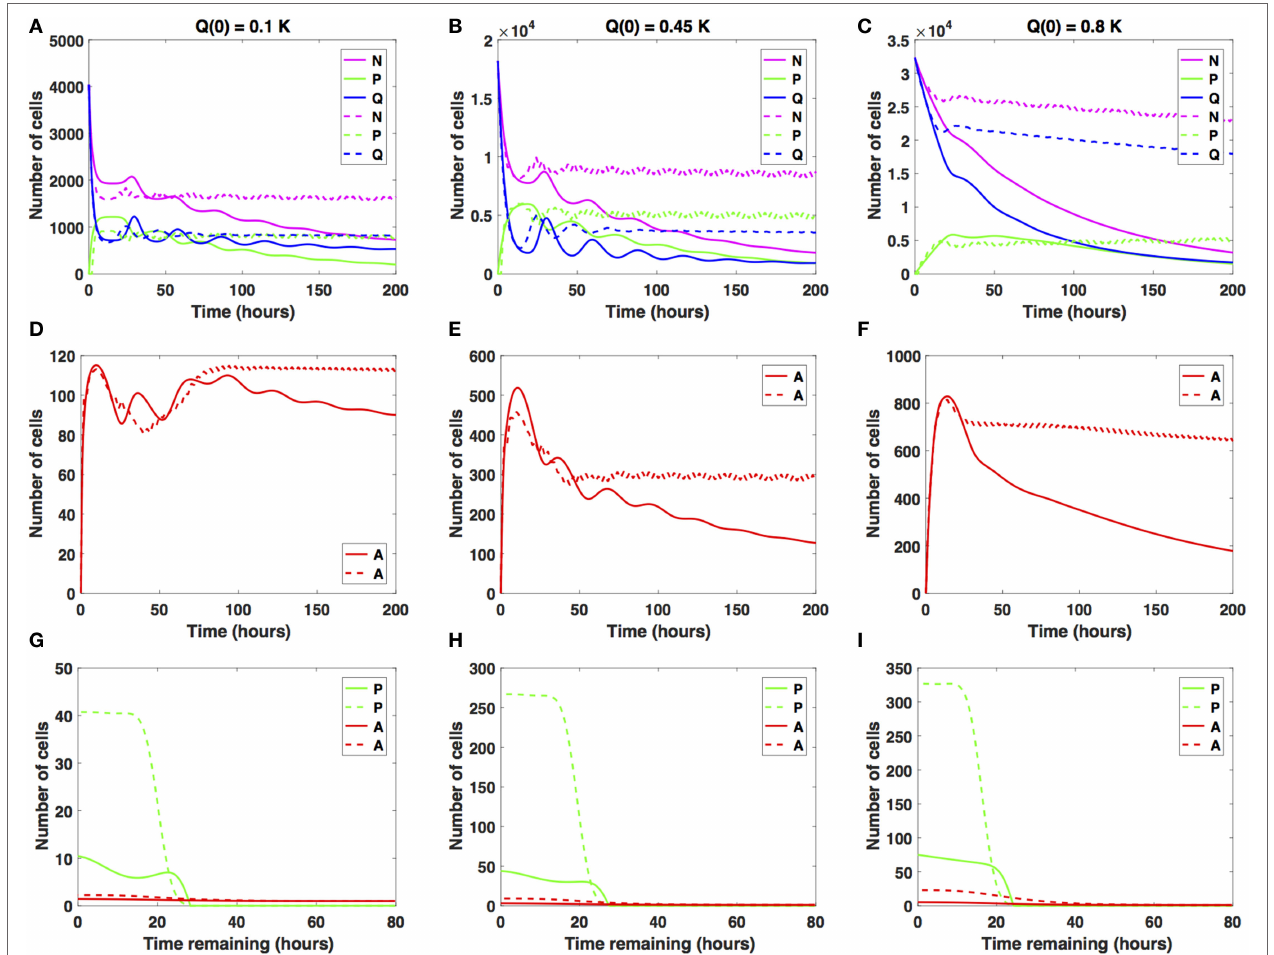
FIGURE 4 | Numerical solutions for the system (1)–(3) given intermediate increases in the average cell-cycle length with (A,D,G) Q (0) = 10%, (B,E,H) Q (0) = 45%, and (C,F,I) Q (0) = 80% of the in vitro carrying capacity, K . The cellular dynamics in each compartment given a sustained, constant mitotic arrest or a switch-on/switch-off arrest is illustrated using solid or dashed lines, respectively. Panels (A–C) show the dynamics of the proliferating ( P ), quiescent ( Q ), and total number of non-apoptotic cells ( N ). (D–F) show the dynamics of the apoptotic cells ( A ). (G–I) illustrate the distribution of the times remaining to be spent by cells in the proliferative ( P ) and apoptotic ( A ) compartments as seen at the end of the simulation time, t = 200h, with (G) Q (0) = 10%, (H) Q (0) = 45%, and (I) Q (0) = 80% of the plate carrying capacity, K